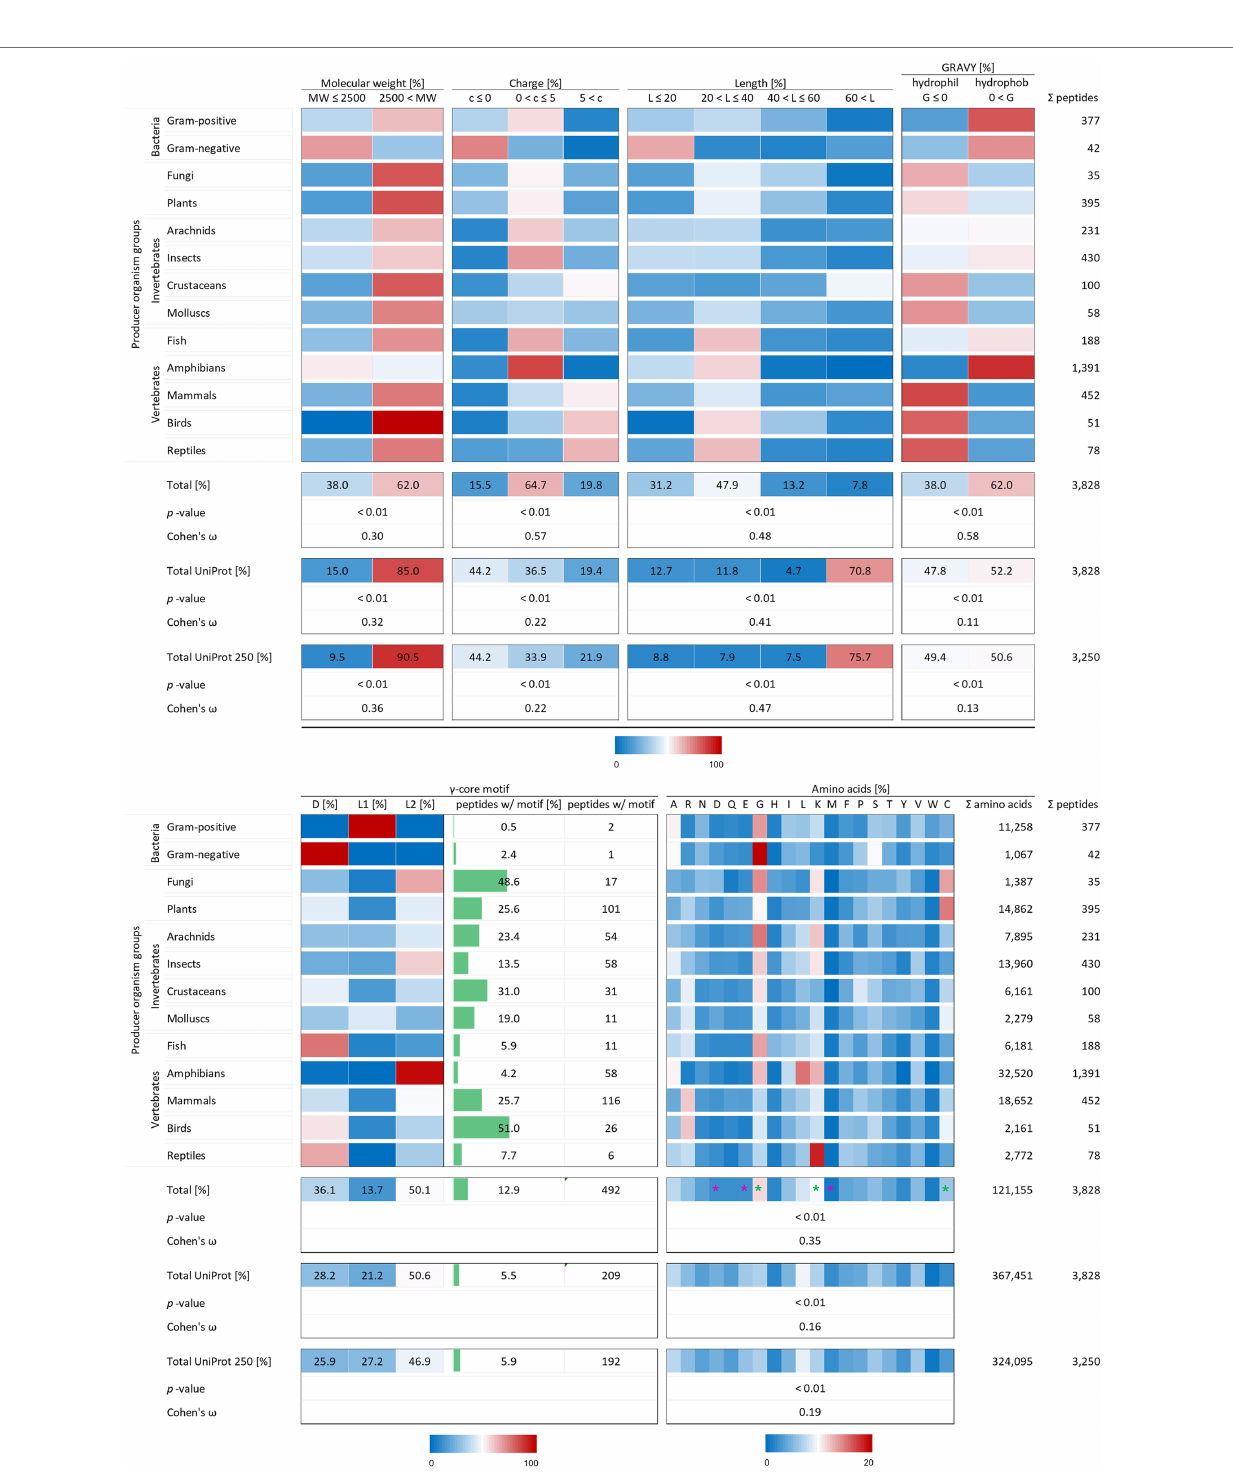
FIGURE 2 | Distribution of AMP properties in different producing organism groups. Data were mined from the APD, DRAMP and DBAASP databases and subsequently processed. Percentage values were used to generate heat maps with blue colour for low and red colour for high values. The margins for the corresponding tables are given directly below the tables. The row ‘Total’ describes the summary of the data of the producer organism rows. The values in the row named ‘Total UniProt’ are from randomly chosen peptides of the peptide database UniProt. The row ‘Total UniProt 250’ displays the results, if the randomly chosen peptides have a total number of 250 for each producing organism group. The association and its magnitude were determined by the p -value and the Cohen’s ω , respectively. Asterisks indicate highest changes for increased (green) and decreased (violet) numbers of amino acid residues compared to randomly chosen peptides from